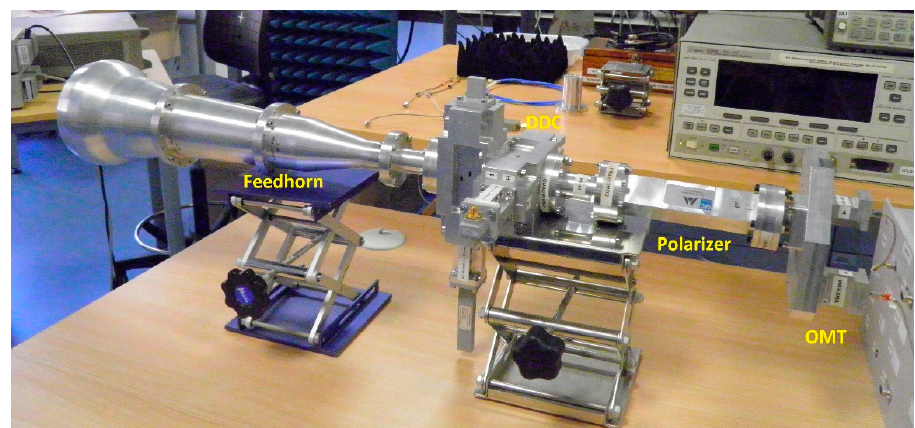
Figure 3. Detail of the antenna-feed system. From left to right: feedhorn, double directional coupler, polarizer and ortho-mode transducer.